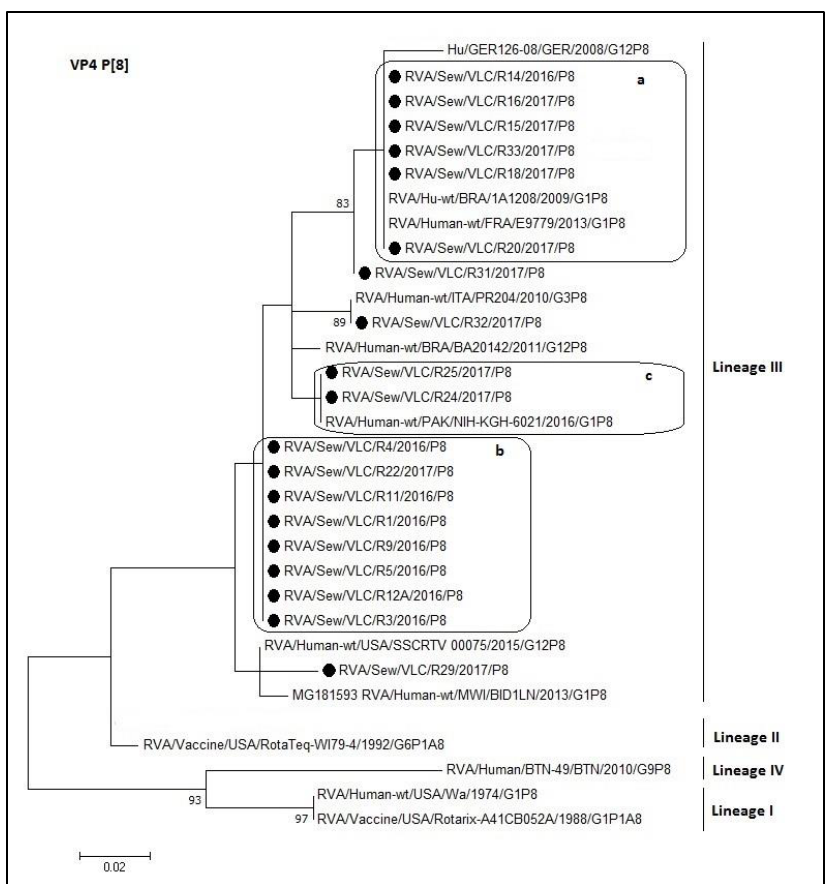
Figure 4. Molecular phylogenetic analysis of P[8] rotavirus (VP4 gene). The evolutionary history was inferred by using the Maximum Likelihood method based on the Tamura 3-parameter model [43] with a bootstrap of 1000 replicates. The tree is drawn to scale, the branch lengths measure the number of substitutions per site. The analysis included 32 nucleotide sequences. There were 127 positions in the final dataset. including nucleotides from 180 to 307. a, b, and c: Boxes containing identical sequences.